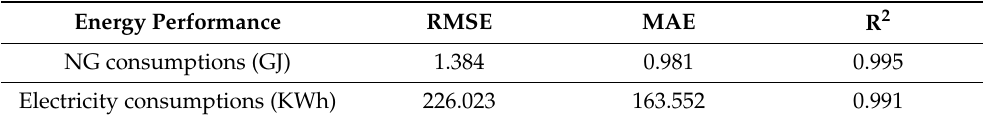
Figure 6. The prediction performance of annual electricity consumption: ( a ) Model Prediction Performance; ( b ) Model Error Performance. Table 3. ANN model